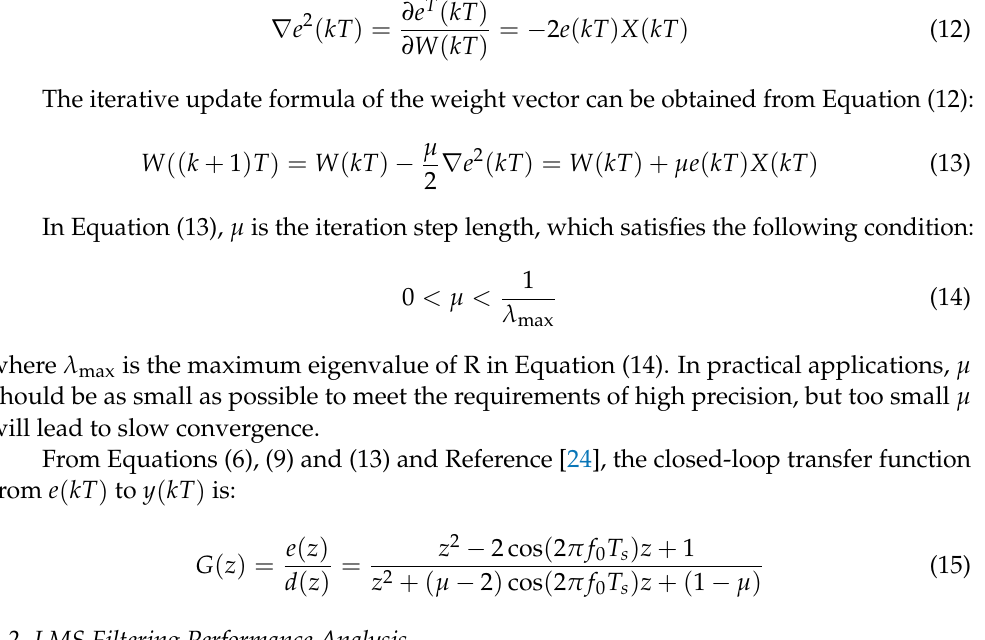
t /s Figure 5. LMS algorithm real-time extraction effect . 4. Experimental Verification 4.1. Experimental Installation To verify the effectiveness of the algorithm in this paper, an experimental platform of maglev high-speed motor is built, and the rotor online unbalanced compensation ex- periment is carried out. The experimental platform is shown in Figure 6. The mechanical structure of the experimental platform includes a motor, a rotor, left and right magnetic bearings, a counterweight plate, and so on. The rotor is driven by the right-end motor, and the left and right magnetic bearings support the rotor. The electronic control part of